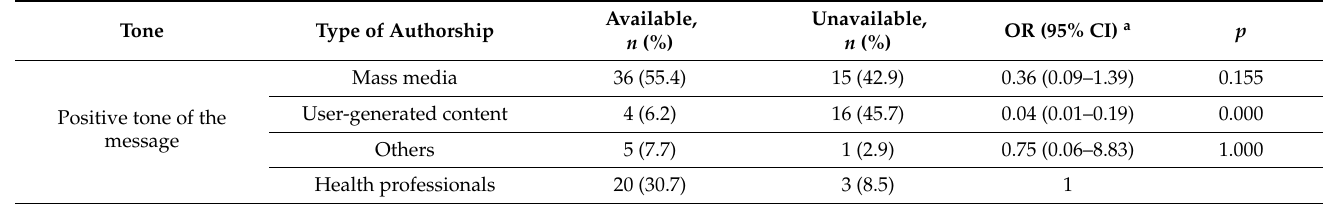
Table 5. Type of authorship and tone of the message.